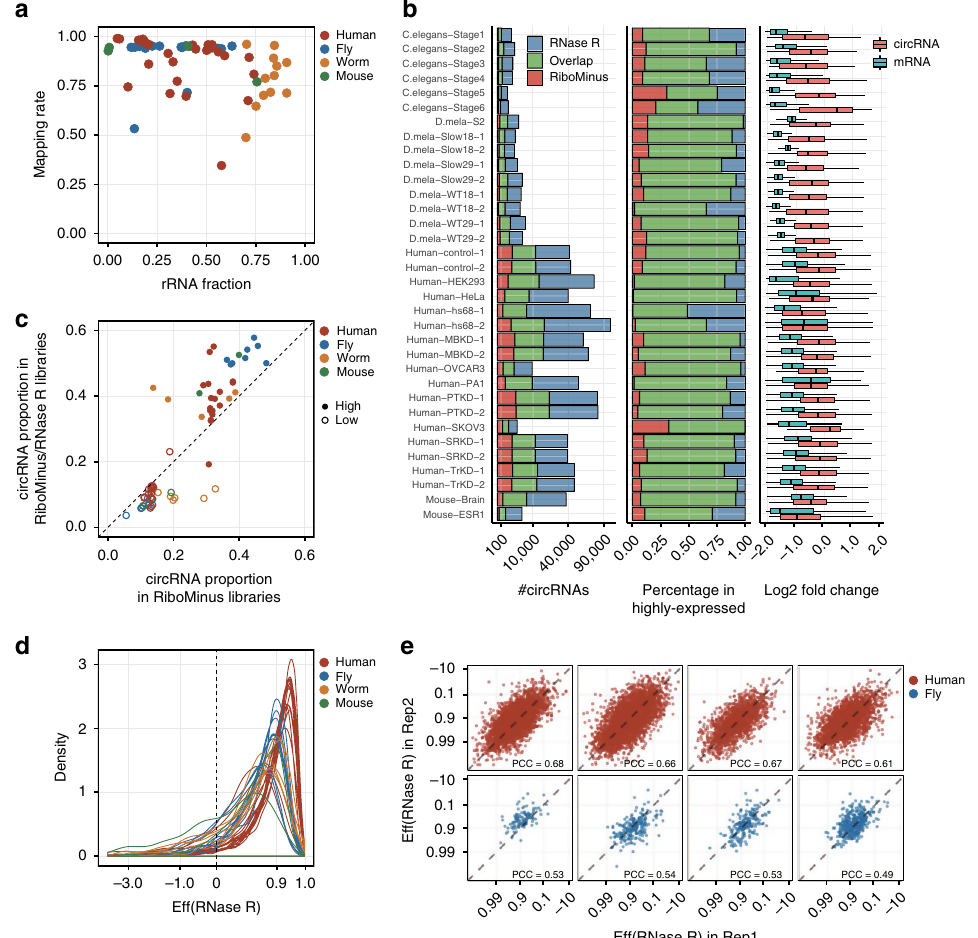
Fig. 1 Challenges in quantifying the expression of circular RNAs. a The fraction of ribosomal RNA reads in 63 RNA-seq datasets from four different species. x - and y -axis represent the fraction of reads mapped to rRNA sequences and the reference genome in all sequencing reads, respectively. b RNase R treatment affects circRNA numbers and their expression levels. Left: total number of detected circRNAs in RiboMinus and RiboMinus/RNase R-treated samples. Middle: percentage of highly expressed circRNAs detected in both RiboMinus and RiboMinus/RNase R samples. Right: Boxplot shows the change of circRNA and mRNA expression levels after RNase R treatment. Expression levels of circRNAs were measured as the number of BSJ reads of each circRNA divided by the total number of BSJ reads. Gene expression levels were measured by TPM (transcript per million). c Proportion of highly (top 50%) and lowly (bottom 50%) expressed circRNAs reads in RiboMinus and RiboMinus/RNase R data. RNase R treatment tends to enrich highly expressed circRNAs but reduce lowly expressed circRNAs. d Density distribution of RNase R enrichment coef fi cient for circRNAs in four species. The vertical dashed line at x = 0 indicates a null enrichment effect of circRNAs. e Replication of RNase R enrichment coef fi cient in two experimental replicates of eight RNA- seq datasets. X- and y-axis represent the log transformed (1 − x ) of RNase R treatment coef fi